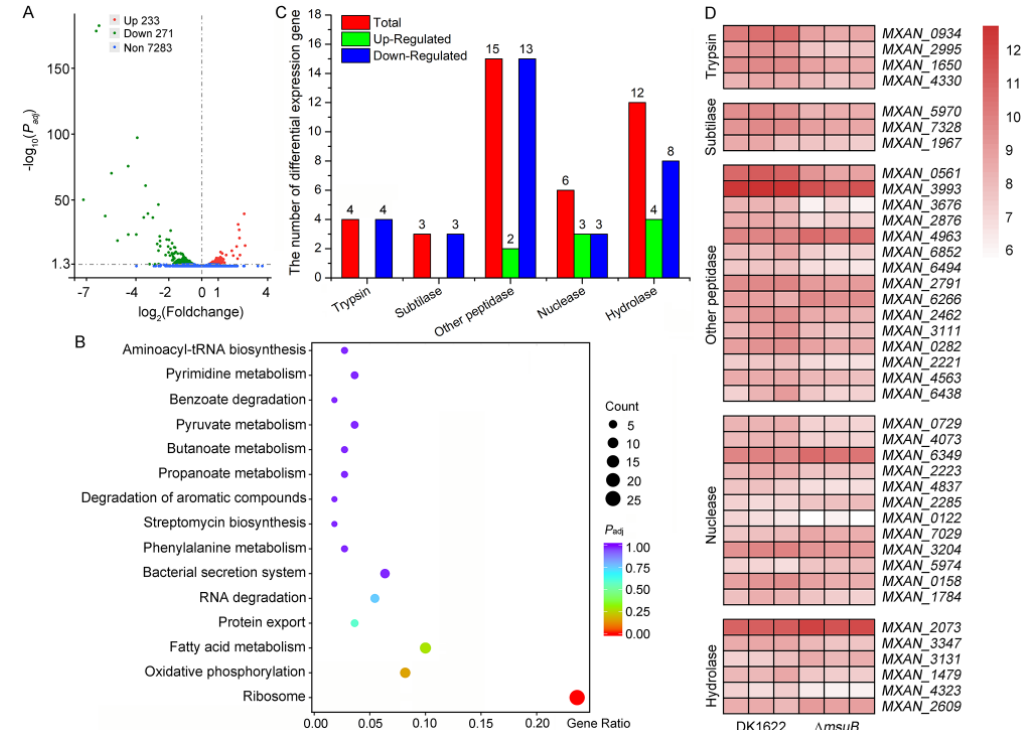
Figure 5. Global transcriptional profiles of DK1622 and the ∆ msuB mutant. ( A ) Volcano plot of differentially expressed genes (DEGs). Red dots and green dots represent the up- and down-regulated genes with significant differences, respectively ( P adj < 0.05). The blue dots represent the genes that did not change significantly. ( B ) KEGG pathway enrichment results of DEGs. The y – axis represents the categories of the KEGG pathways. The x – axis is the richness factor (richness factor = amount of DEGs in the pathway divided by the amount of all genes in the background gene set). ( C ) Analysis of the DEGs encoding lytic enzymes. ( D ) Heatmap of RNA sequencing, showing the expression pattern of genes encoding lytic enzymes in DK1622 and the ∆ msuB mutant, respectively. The normalized FPKM value of differentially expressed genes was used for plotting.